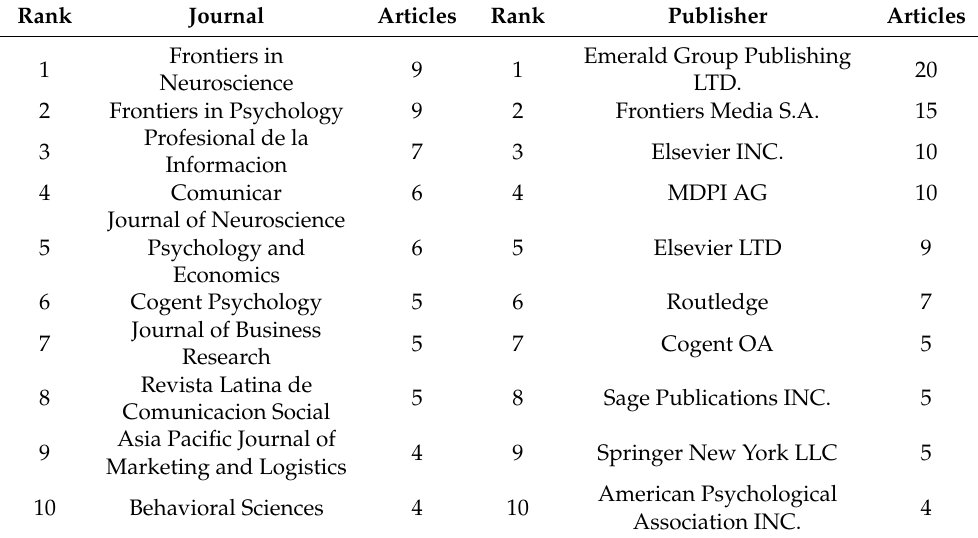
Table 2. Top ten journals and publishers in neuromarketing research